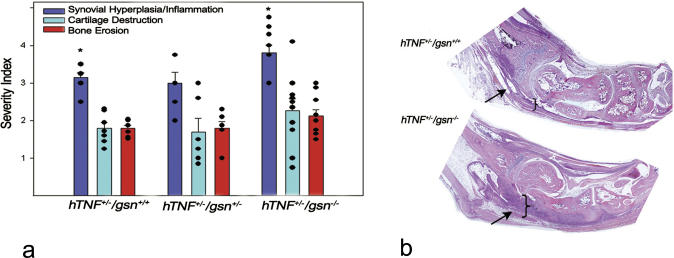
Knocking out Gelsolin Expression Results in Disease Exacerbation(A) Histopathological scores. * p = 0.025 n = 8–11.(B) Representative histopathological analysis (stained with haematoxylin-eosin) of arthritic joints. Shown images were assembled from multiple overlapping sections. Arrows indicate the synovial membrane.